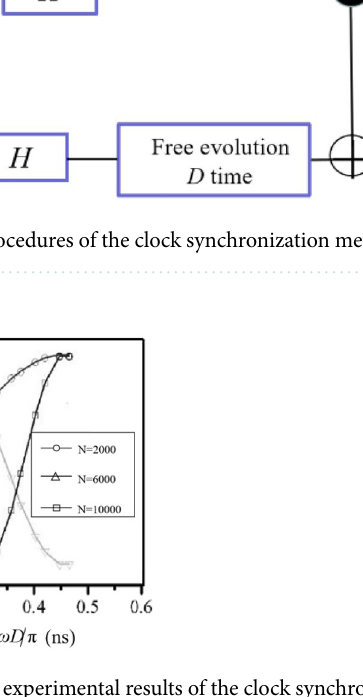
Figure 2. The theoretical and experimental results of the clock synchronization method based on quantum